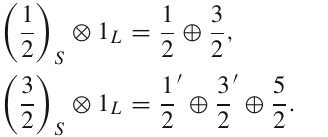
2 Inner structures of the c ( ss )